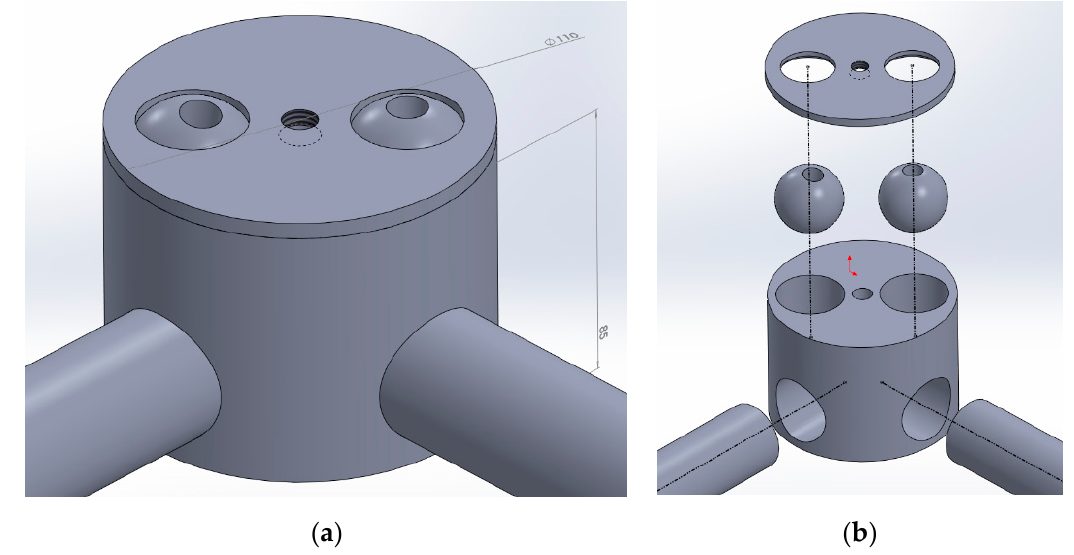
Figure 8. Structural node version 2: assembly view ( a ); exploded view ( b ).